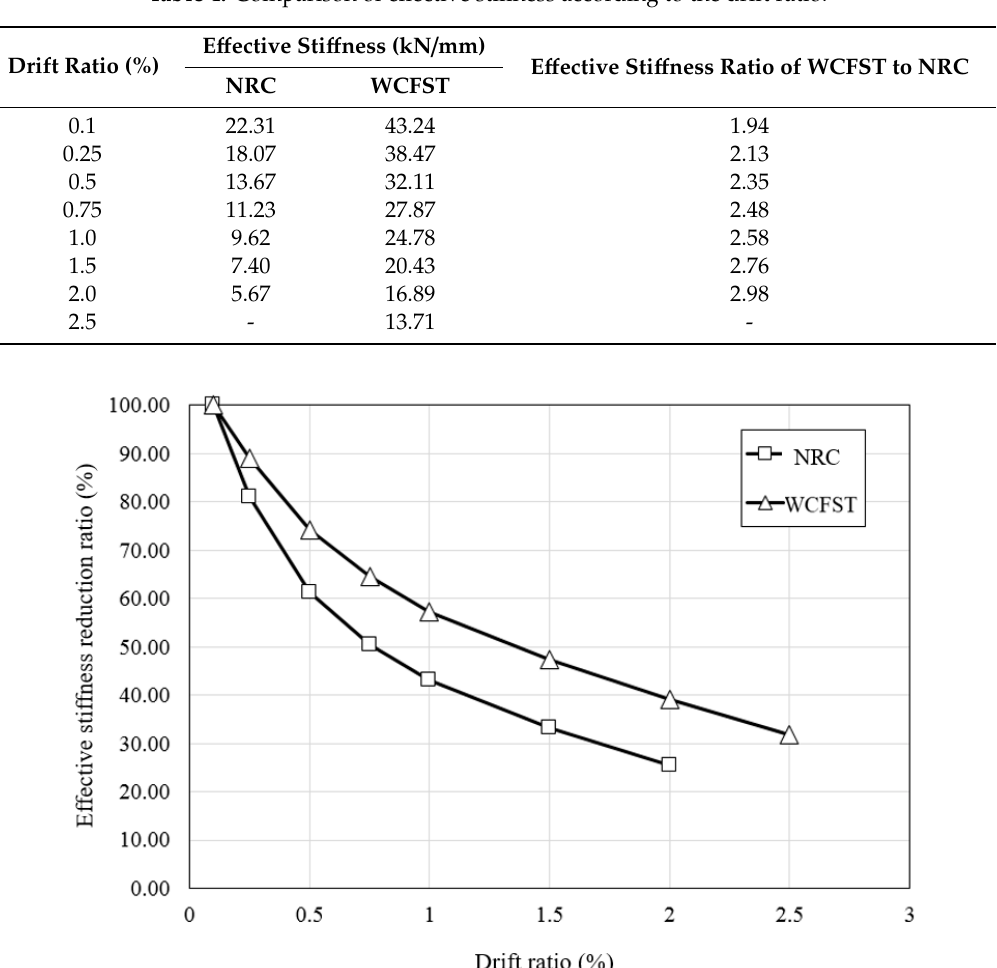
Figure 12. Effective stiffness reduction ratio when compared to the initial stiffness. Figure 12. E ff ective sti ff ness reduction ratio when compared to the initial sti ff